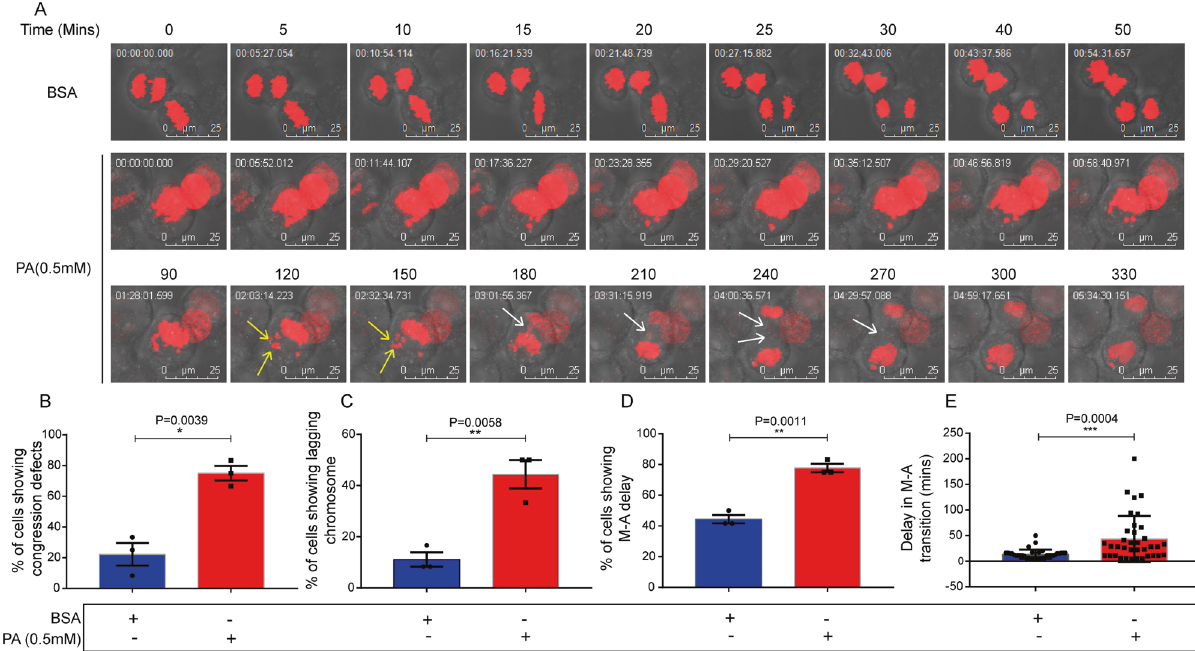
Fig. 5 PA exhibits abnormal chromosomal segregation alongside congression defects. Stills from time-lapse videos featuring transiently expressed H2B mCherry in HepG2 cells that were treated with control vehicle (upper lane) and 0.5 mM PA (lower last two-lane). Images ensure a stipulated time frame for cell division in both cases. Cells treated with PA showed chromosomal congression defects and metaphase to anaphase delay. Yellow arrows show an unaligned chromosome. Along with the delay in metaphase to anaphase transition, lagging chromosomes (indicated by white arrows) were also observed, which is a hallmark of aberrant chromosomal segregation, during PA-induced lipotoxicity ( A ). Quantify the fraction of mitotic cells showing chromosome congression defects upon PA treatment ( B ). A representative graph shows the percentage of lagging chromosomes within a fraction of mitotic cells ( C ). The number of cells showing metaphase (M) to anaphase (A) delay was quanti fi ed ( D ), followed by measuring the delay in times (mins) ( E ). For B – D , individual dots represent value from individual biological replicates. Unpaired two-tailed t test were applied for statistical analysis. The graphs represent N = 3 independent experiments, with a minimum of 12 mitotic cells per experiment. In addition, each dot in scatter plot E represents the M-A transition period for one cell. A total